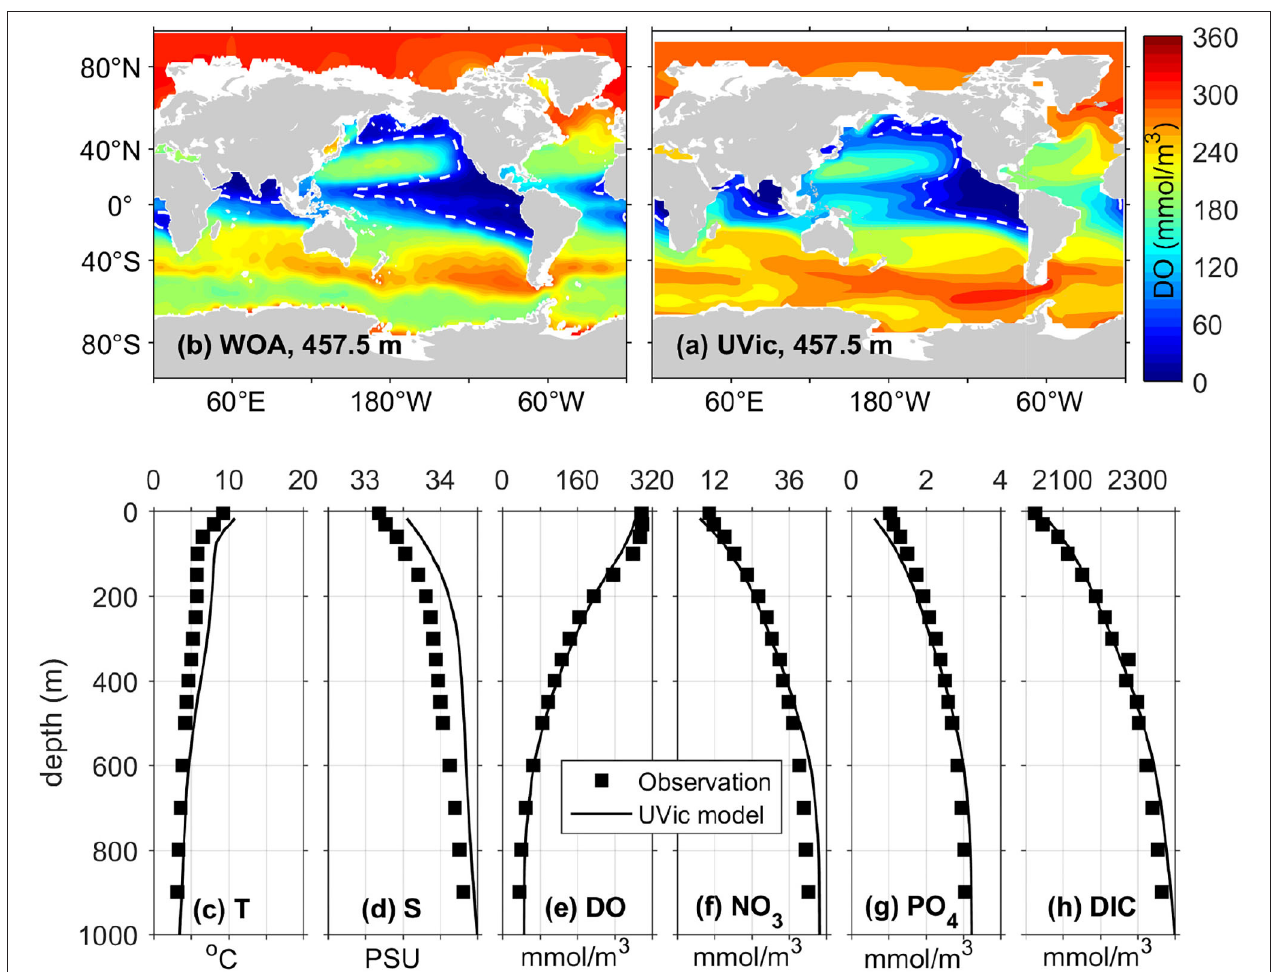
FIGURE 2 | Model-data comparison: (a) Simulated and (b) observed global oxygen pattern at a depth of 457.5 m; (c–h) simulated (lines) and observed (scatter) basin averaged profiles of key model tracers within the WSNP (T, temperature; S, salinity; DO, dissolved oxygen; NO 3 , nitrate; PO 4 , phosphate; DIC, dissolved inorganic carbon). All the observations are derived from the World Ocean Atlas 2018 (WOA 2018) ( Garcia et al., 2019), expect for the DIC profile derived from GLODAPv2.2020 ( Olsen et al., 2019, 2020). The observational data are collected on or after 1960, and model outputs for the historical comparisons are averaged between 1960 and 2020. In (a,b) , white dash lines delineate the contour of low-oxygen areas ( O 2 <60 mmol/m 3